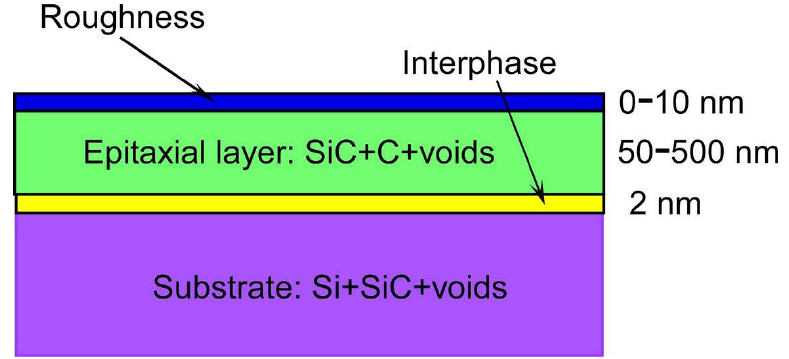
Figure 3. Ellipsometric model used in the processing of the experimental spectra of 3C-SiC/Si(111) samples.